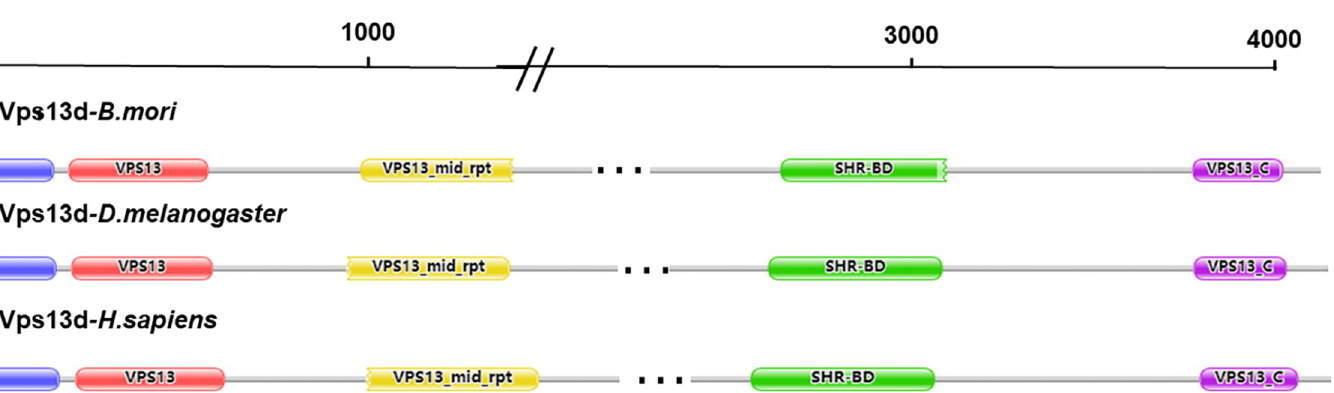
Fig 1. Homology comparison of Vps13d proteins and the domains analysis of Vps13d proteins in B . mori , D . melanogaster , and H . sapiens . The blue rectangle represents the Chorein_N domain. The red rectangle represents the VPS domain. The yellow rectangle represents the VPS_mid_pt domain. The green rectangle represents the SHR-BD domain. The purple rectangle represents the VPS13_C